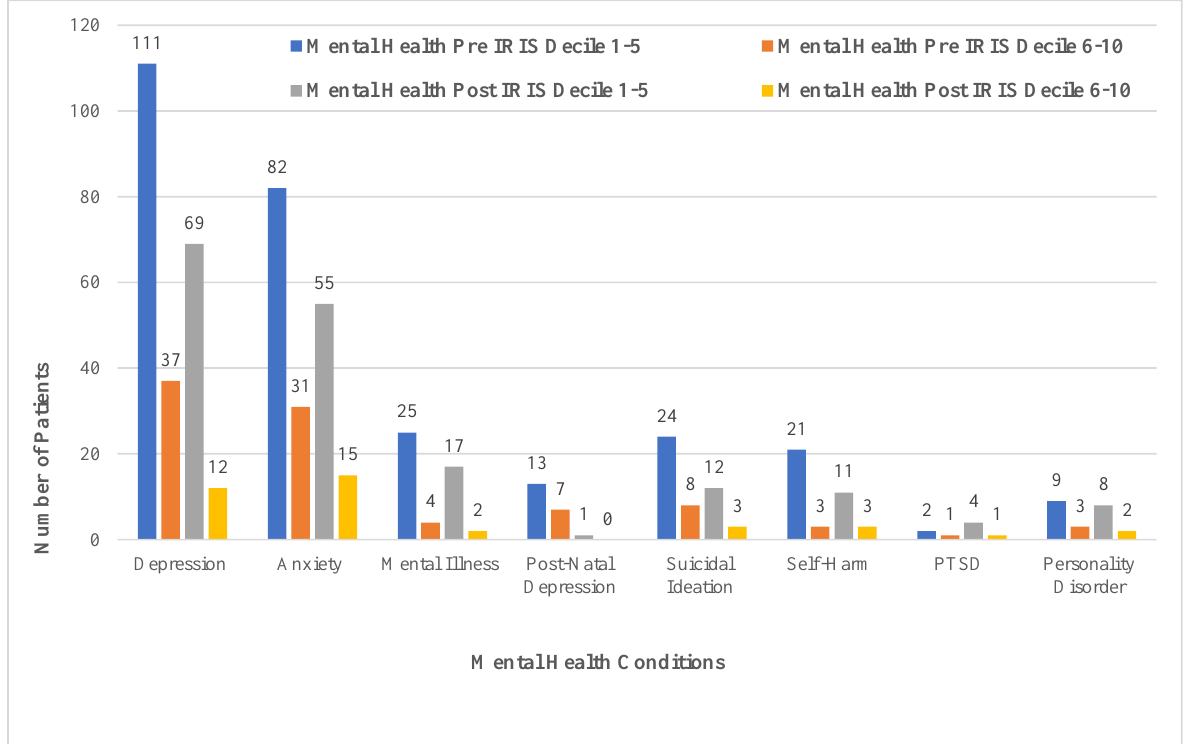
Figure 4. Comparison of mental health conditions and deprivation decile ( n = 250). Figure 5 shows the genitourinary health conditions of the 250 patients related to dep- rivation decile. The health data were mapped according to decile information, and all in- dicated a decrease post-IRIS intervention. Pre-IRIS in deciles 1 – 5, 22% ( n = 54) of the sam- ple had recorded the broader gynaecological conditions, 3% ( n = 8) was recorded for STIs and 16% ( n = 41) recorded for UTIs. Pre-IRIS in deciles 6 – 10, 6% ( n = 16) had gynaecological conditions, 0% had STIs and 7% had UTIs recorded. Post-IRIS in deciles 1 – 5 gynaecologi- cal conditions, STIs and UTIs were recorded at 6% ( n = 15), 0.4% ( n = 1) and 6% ( n = 14), respectively. Post-IRIS 6 – 10, gynaecological conditions, STIs and UTIs were recorded at 2% ( n = 5), 0% and 2% ( n = 6), respectively.